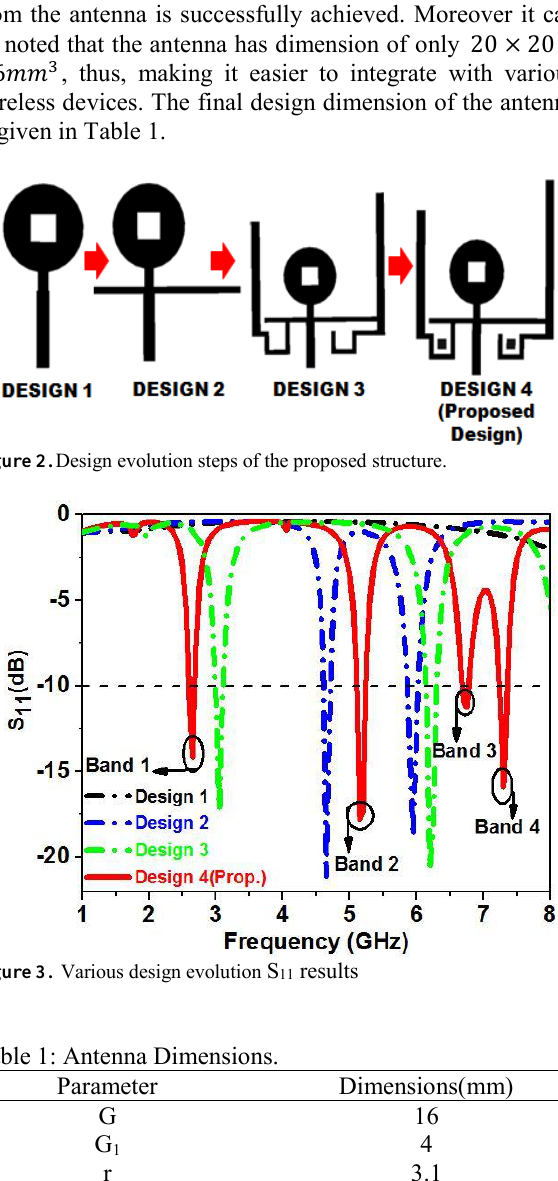
Figure 3. Various design evolution S 11 results